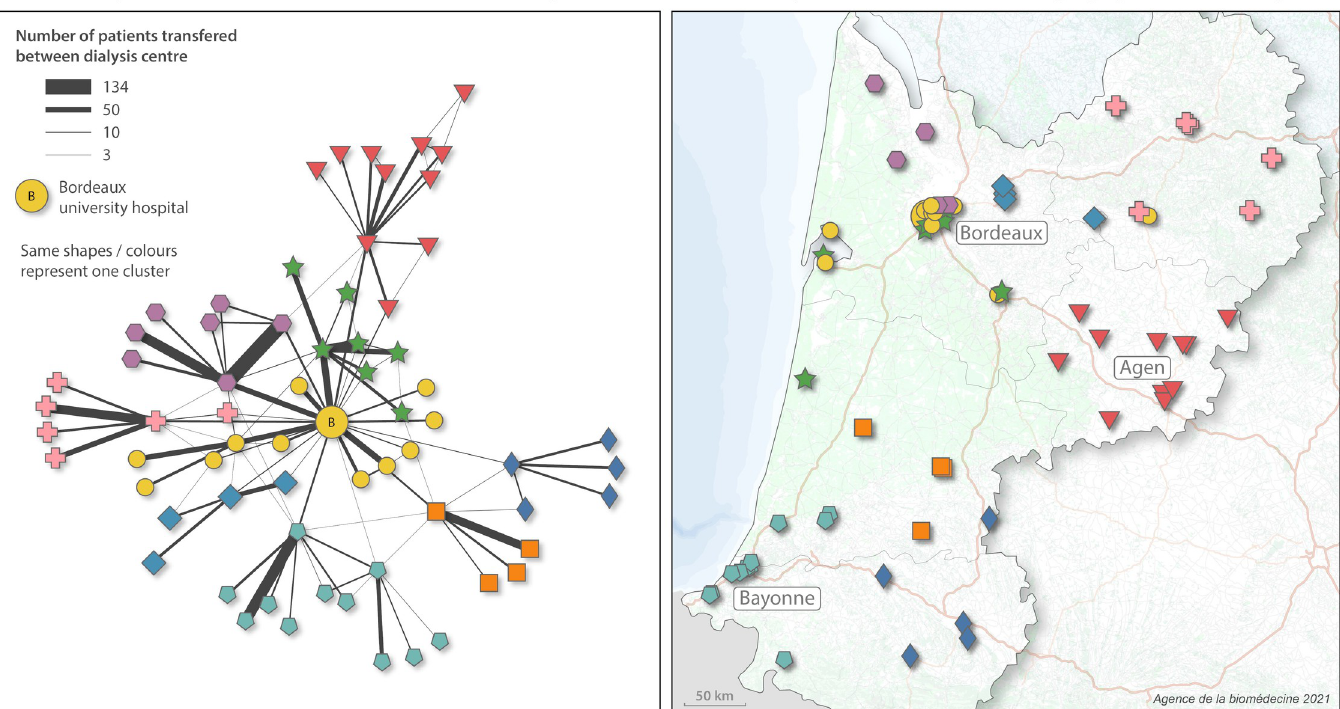
PLOS ONE | https://doi.org/10.1371/journal.pone.0276068 October 20,